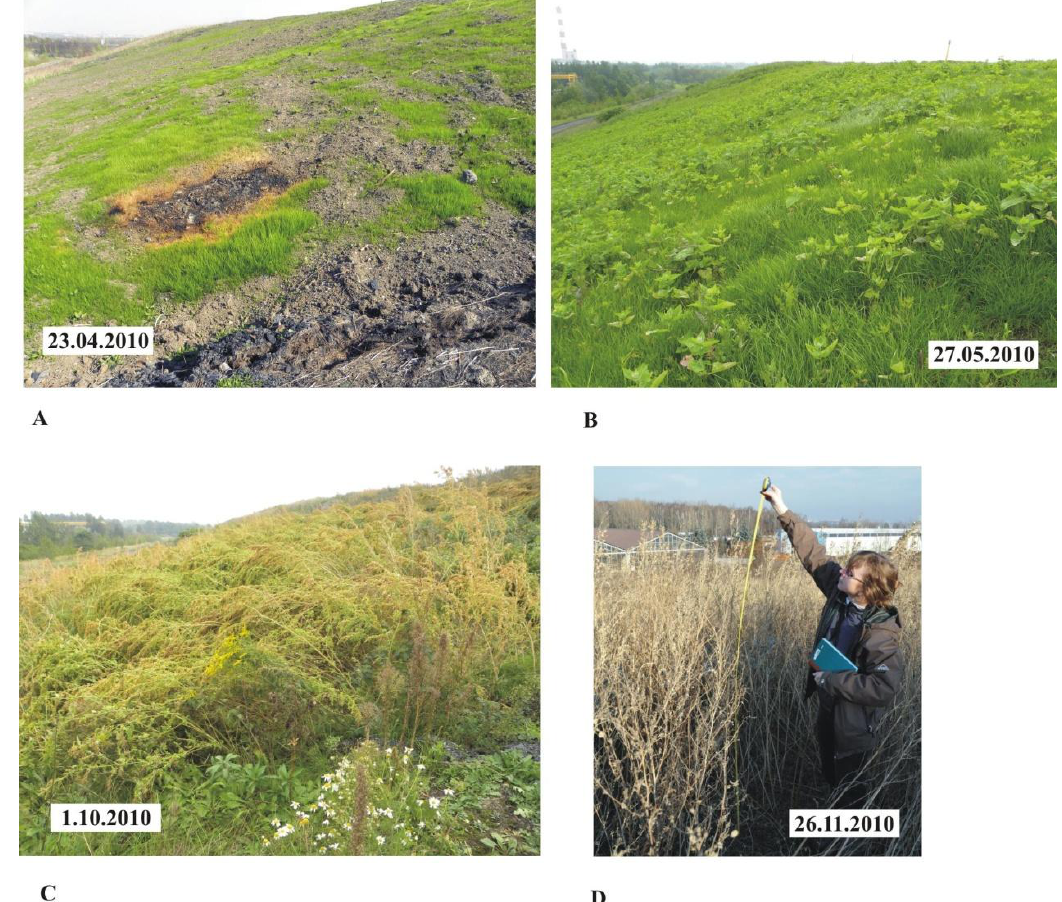
Fig. 4. The rebuilt central part of the northern slope of the Katowice-Wełnowiec dump. A – ew grass sown on the rebuilt part